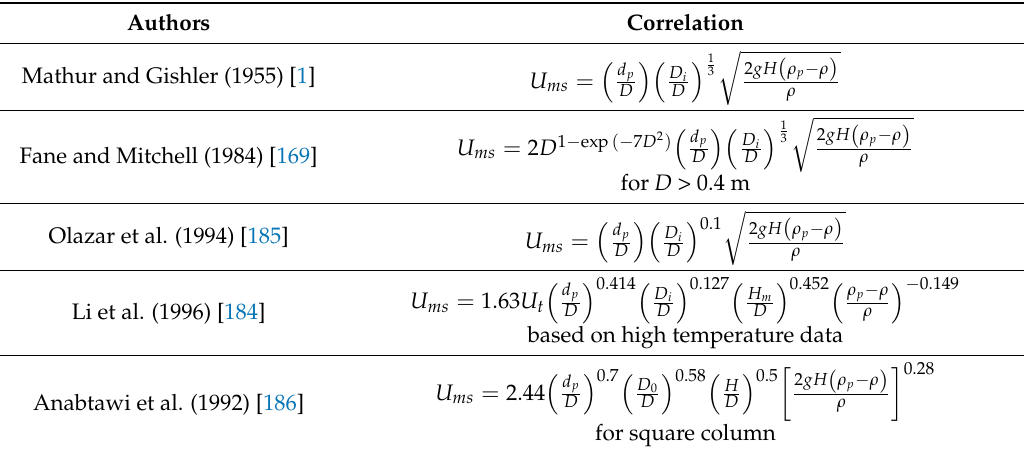
Table 5. Most applied correlations for U ms